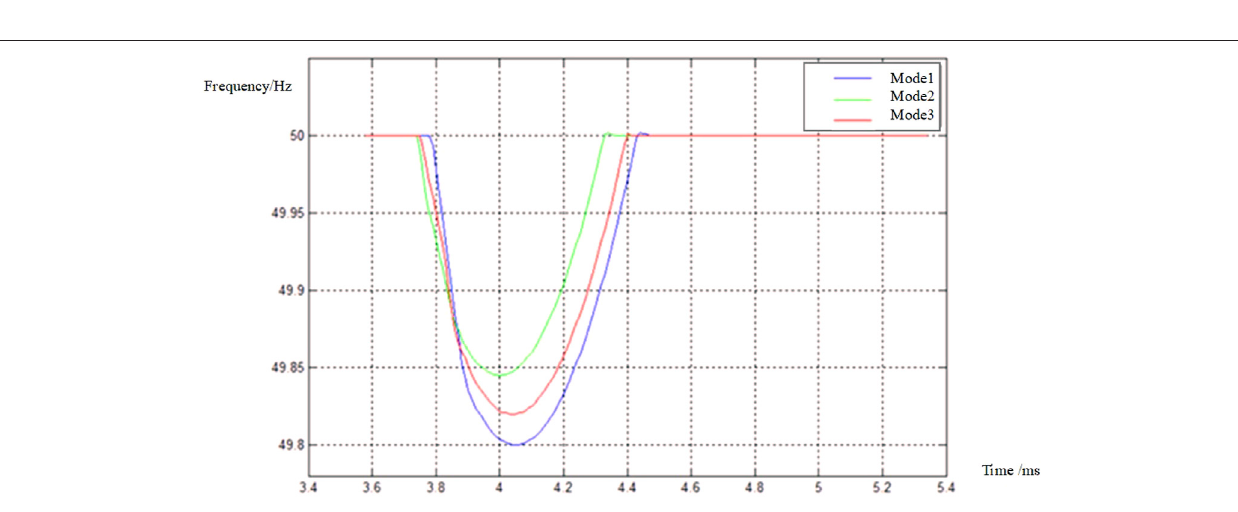
FIGURE 9 | The frequency variation curve in three